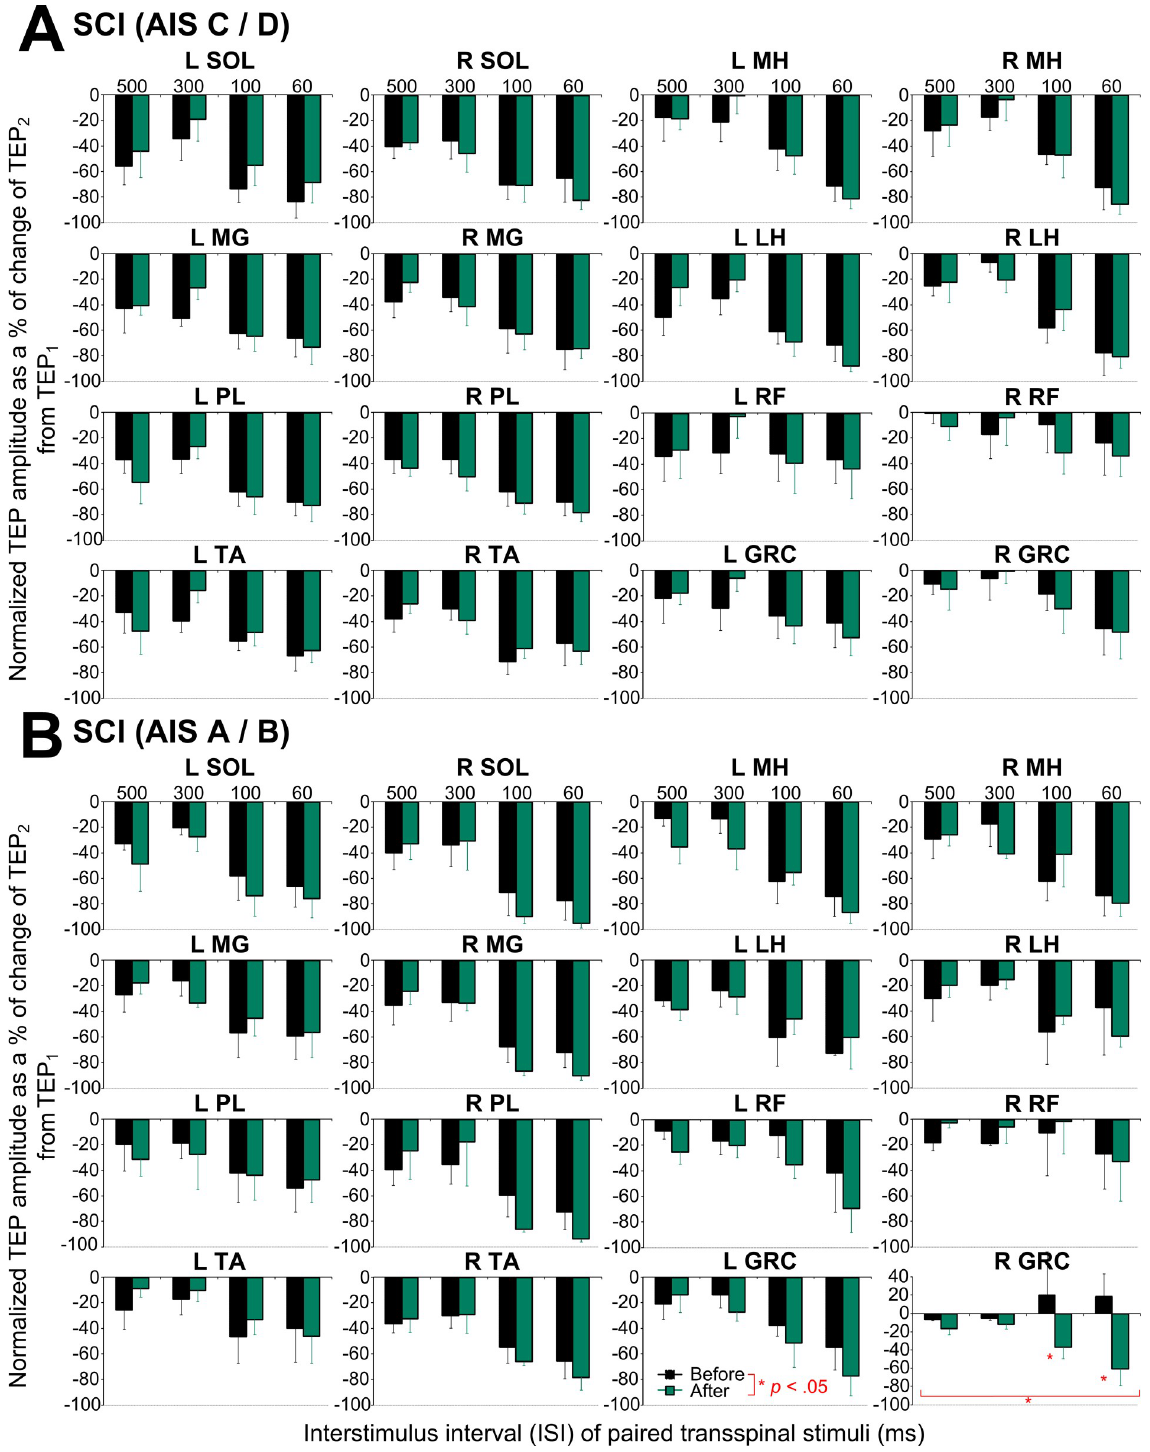
Fig 6. Postactivation transspinal evoked potential (TEP) depression upon paired transspinal stimuli before and after transspinal stimulation in spinal cord injury (SCI). Overall amplitude of the second TEP (TEP 2 ) as a percentage of the first mean homonymous TEP amplitude (TEP 1 ) evoked at interstimulus intervals of 500, 300, 100 and 60 ms at a constant stimulation frequency of 0.2 Hz for participants with (A) AIS C-D and (B) AIS A-B. SOL: soleus; MG: medial gastrocnemius; TA: tibialis anterior; PL: peroneus longus; MH: medial hamstring; LH: lateral hamstring; RF: rectus femoris; GRC: gracilis. Error bars indicate SE. An asterisk indicates a significant difference before and after the transspinal stimulation. https://doi.org/10.1371/journal.pone.0213696.g006 PLOS ONE | https://doi.org/10.1371/journal.pone.0213696 March 7,